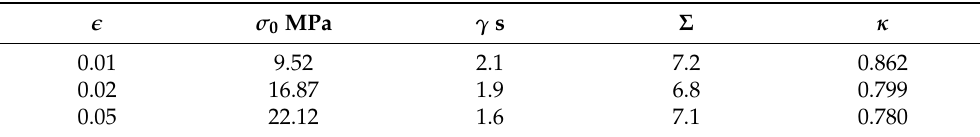
Table 1. Material parameters for the viscoelastic